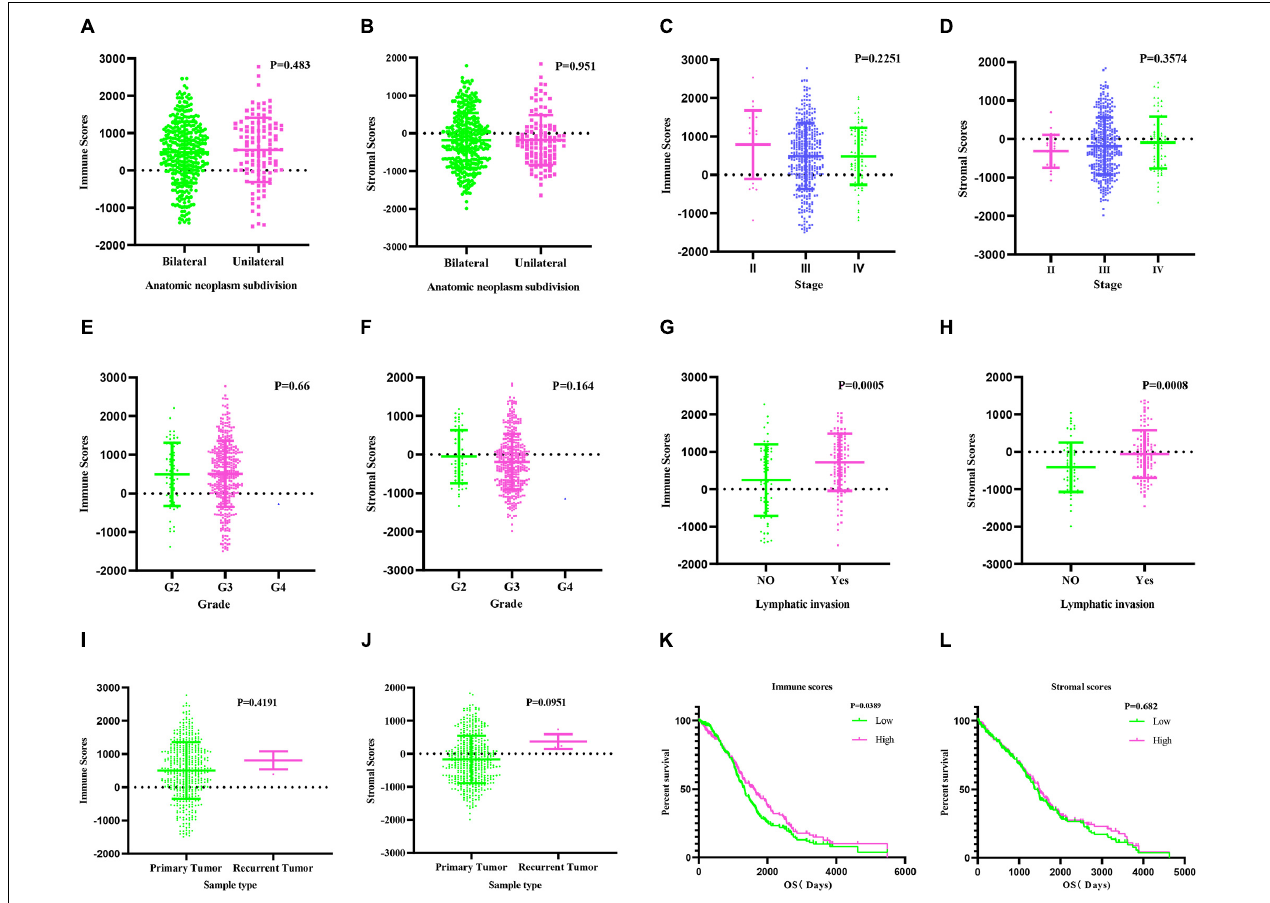
FIGURE 1 | Immune and stromal scores are correlated with ovarian cancer clinical characters and their overall survival. (A,B) Distribution of immune and stromal scores of ovarian cancer anatomic neoplasm subdivision. (C,D) Distribution of immune and stromal scores of ovarian cancer stage. (E,F) Distribution of immune and stromal scores of ovarian cancer grade. (G,H) Distribution of immune and stromal scores of ovarian cancer lymphatic invasion. (I,J) Distribution of immune and stromal scores of ovarian cancer sample type. (K) Kaplan–Meier (KM) overall survival (OS) curve for high and low immune score group. (L) KM survival curve showing the OS time of high and low stomal score